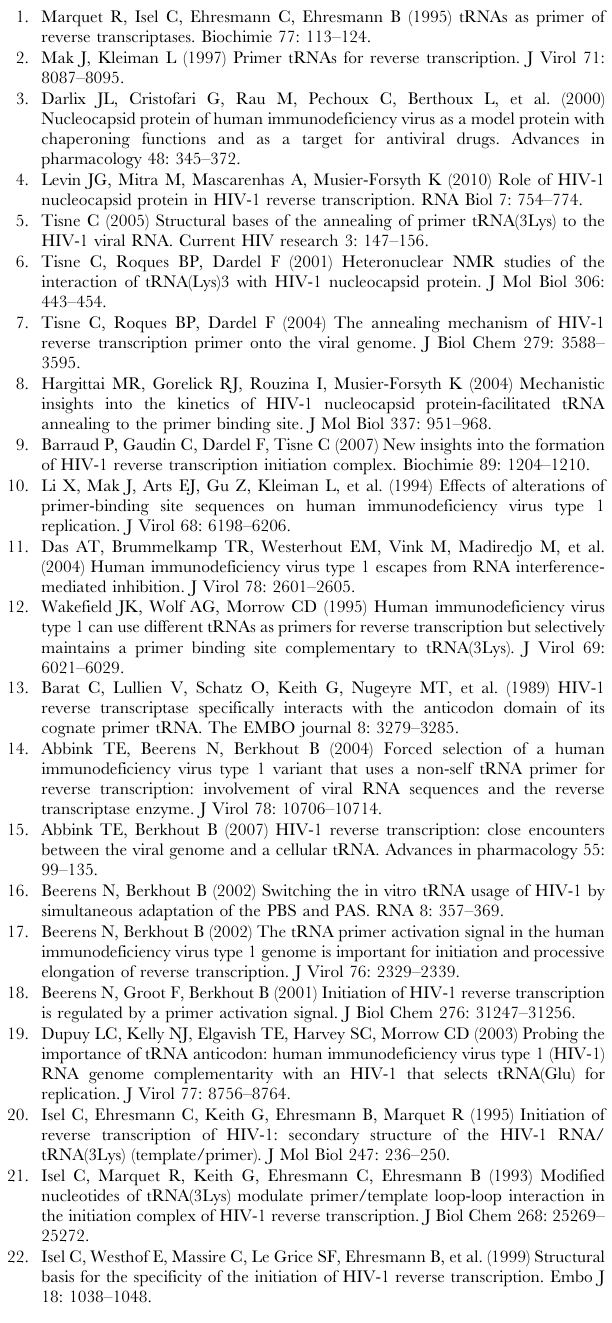
Figure S4 Annealing of PAS ss to tRNA Lys 3 in the presence of PBS. Superimposition of two TROSY experiments recorded at 15 u C showing the imino groups of tRNA Lys 3 (0.1 mM), in black: in complex with PBS (1 equivalent) and PAS ss (1 equivalent) after the heat-annealed procedure; and in red: in complex with PBS (1 equivalent) and PAS ss (1 equivalent) after the NCp7-mediated procedure. Only the GC regions are shown since the T54 imino group was not observed in these experiments. Figure S5 UV melting curve of the PAS ds . (TIF)